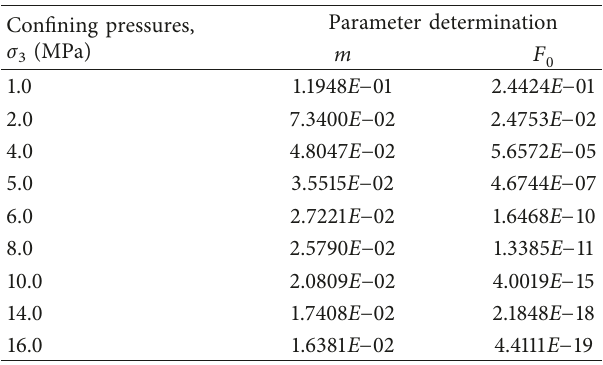
Figure 10: Comparisons between experimental data and predicted results under different confining pressures. Table 3: Parameter determination of the damage constitutive model of